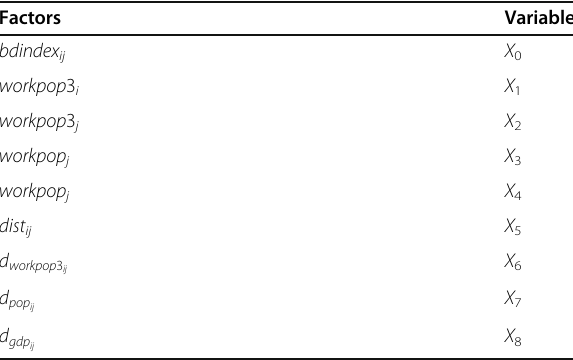
Table 2 Explanation of variables in Eq. (5)